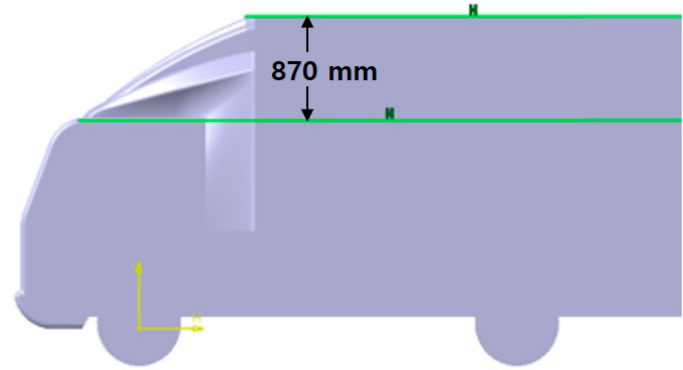
Figure 4. 3D modelling result for CFD analysis.